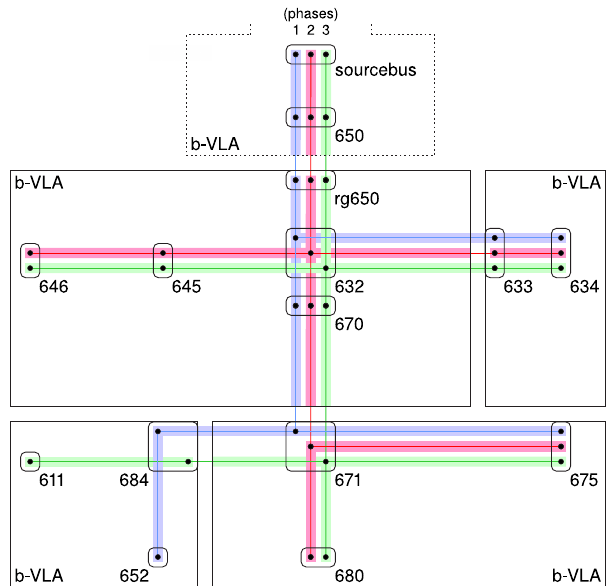
Figure 6. b-VLAs resulting from ph-VLAs (similar results for b-OLAs).